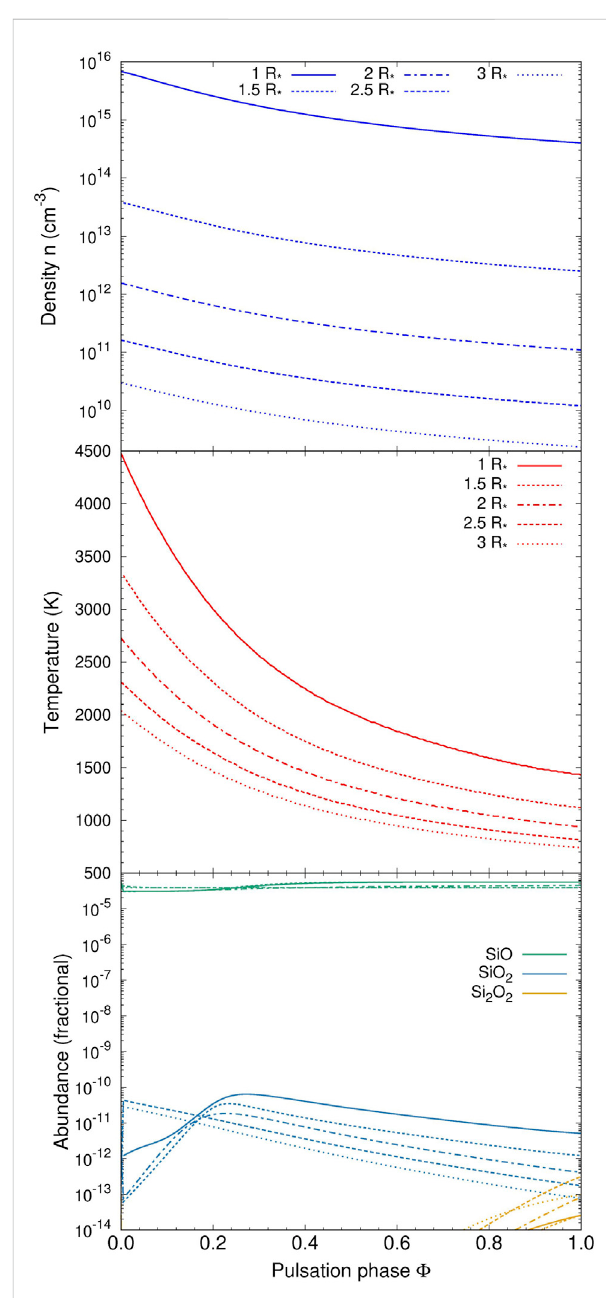
FIGURE 14 Density(top),temperature(middle),andfractionalabundancesin thekineticmodelofanoxygen-richAGBstarasafunctionofpulsation phase (see text for